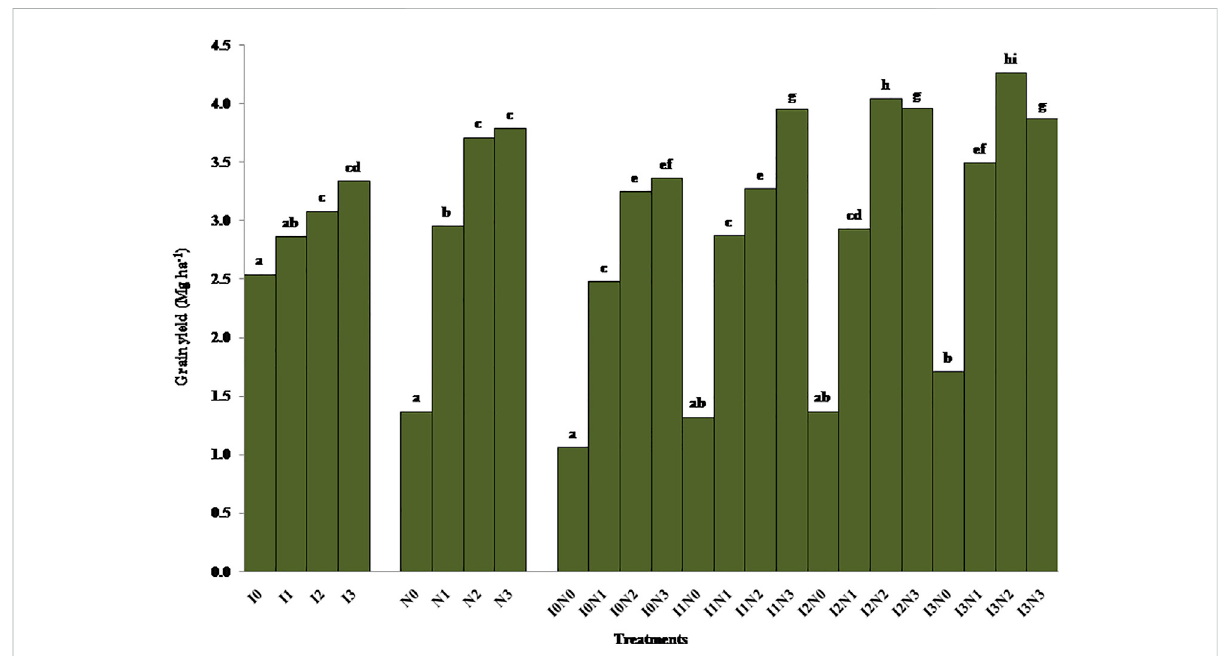
FIGURE 3 Effect ofirrigation andnitrogenlevelsonthegrain yield underzero-tilled wheatcrop of theTeraiagro-ecological zoneineasternIndia (pooled analysis) (means of similar lowercase letters are not signi fi cant at p < 0.05 based on